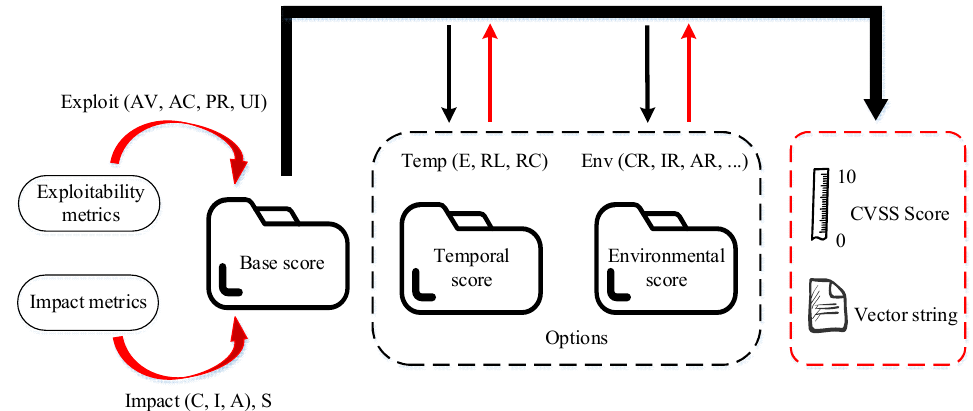
Figure 4. Score calculation in the common vulnerability scoring system (CVSS).